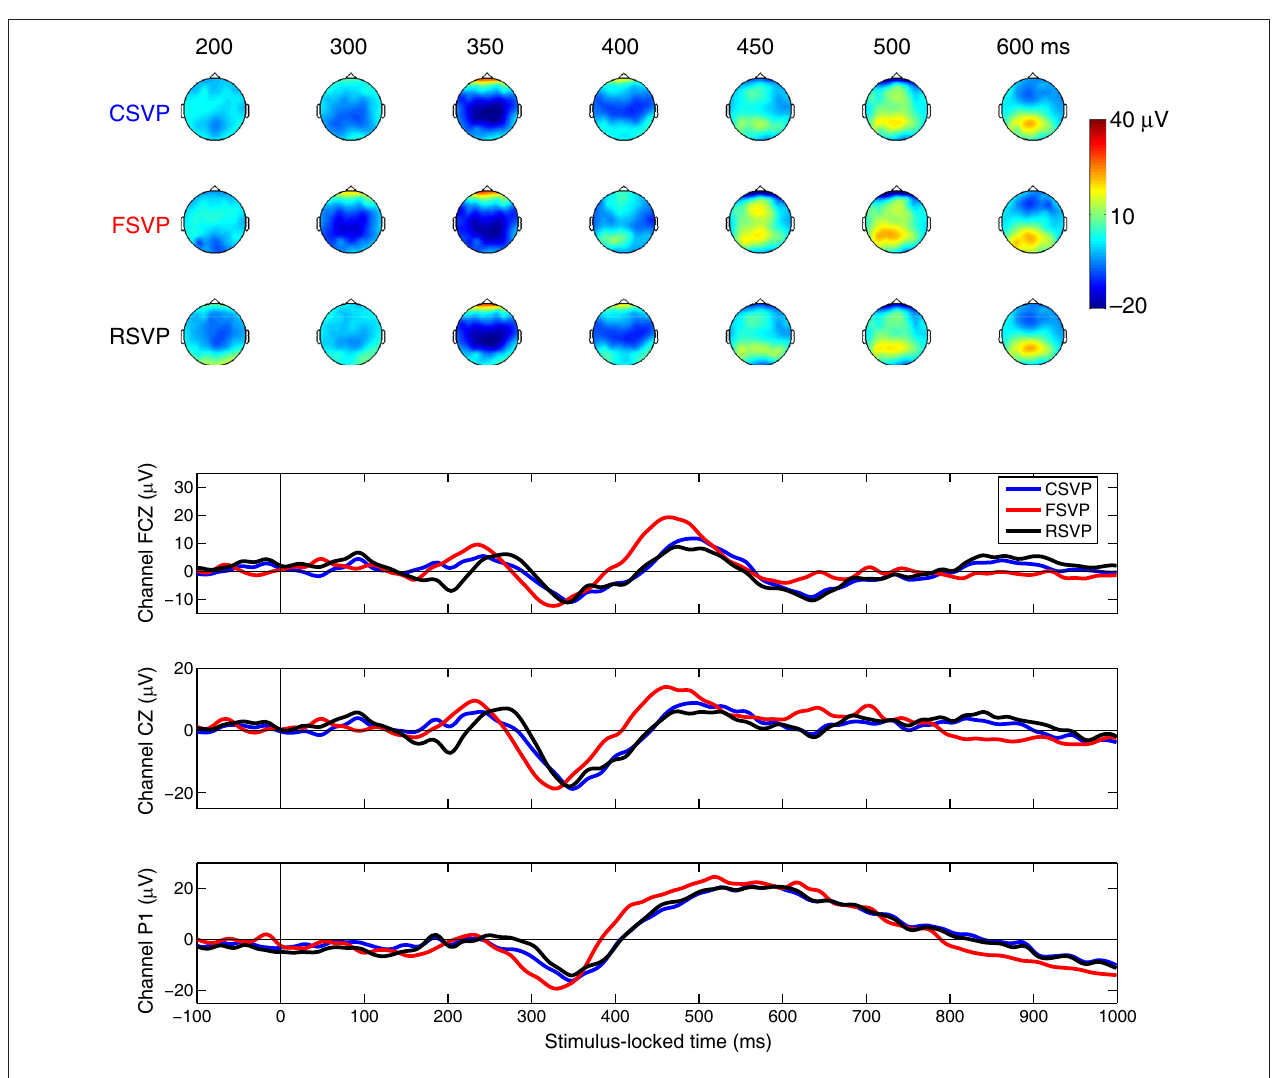
FIGURE 3 | Topologies of ERP differences (target minus distractor trials). Top: Scalp plots of group average EEG difference to CSVP (row 1), FSVP (row 2), and RSVP (row 3) stimuli (locked to stimulus onset). Bottom: Group average ERP difference on channels FCZ, CZ, and